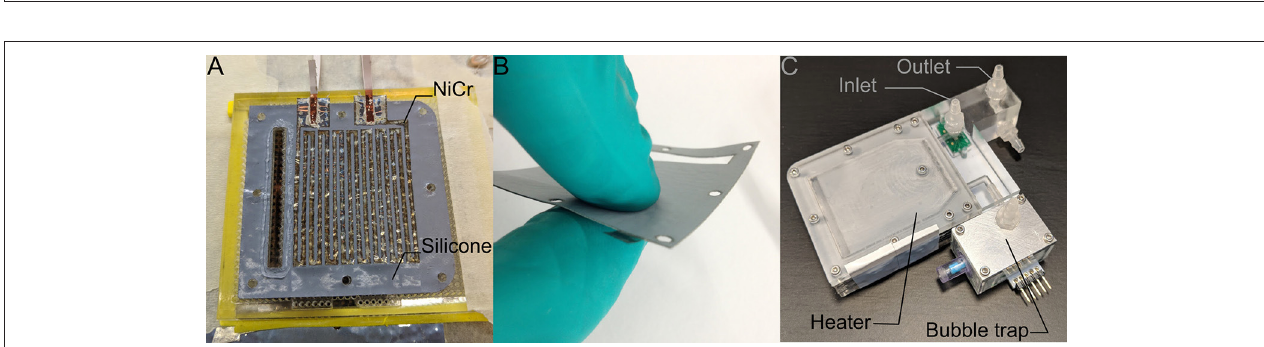
FIGURE 3 | Cross-section of the CAD model of the heater assembly showing how the five heating elements are arranged to maximize heated area per volume.